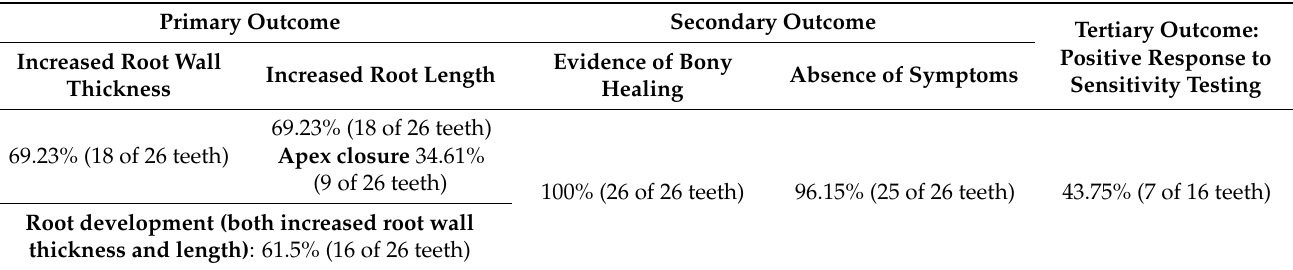
Table 9. Success rates obtained in adult permanent immature teeth performed by REP through randomized clinical